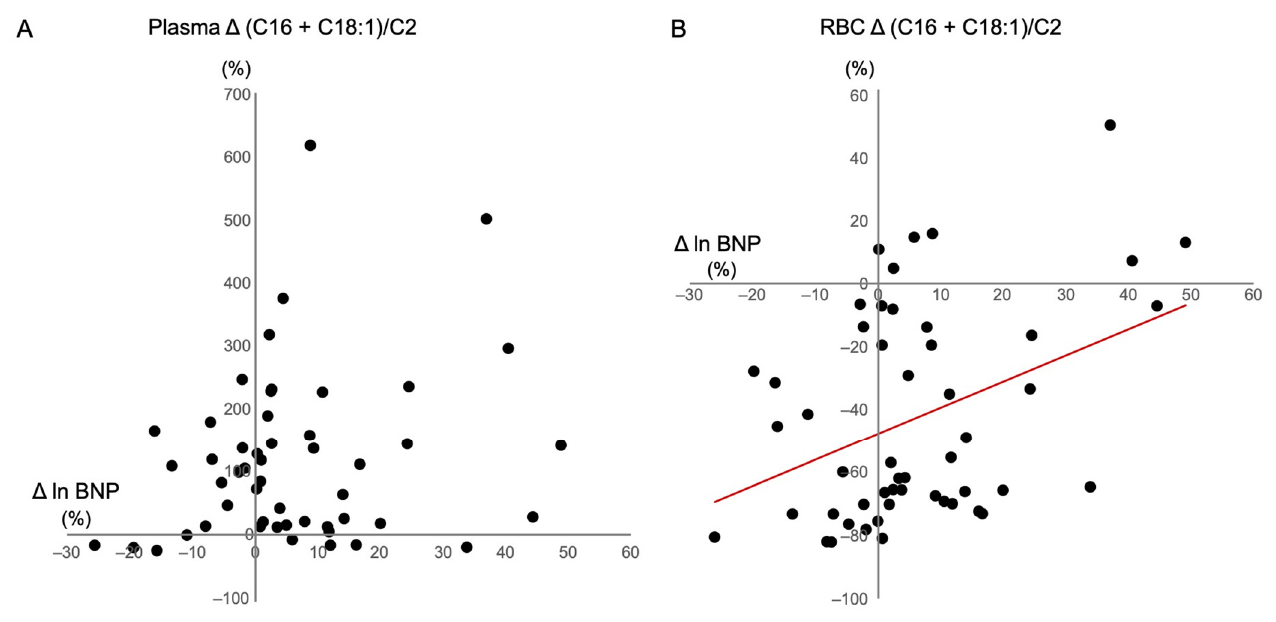
Figure 5. Correlation between changes in BNP with (C16 + C18:1)/C2 in ( A ) plasma; and ( B ) RBCs. BNP: B-type natriuretic peptide; RBC: red blood cell.